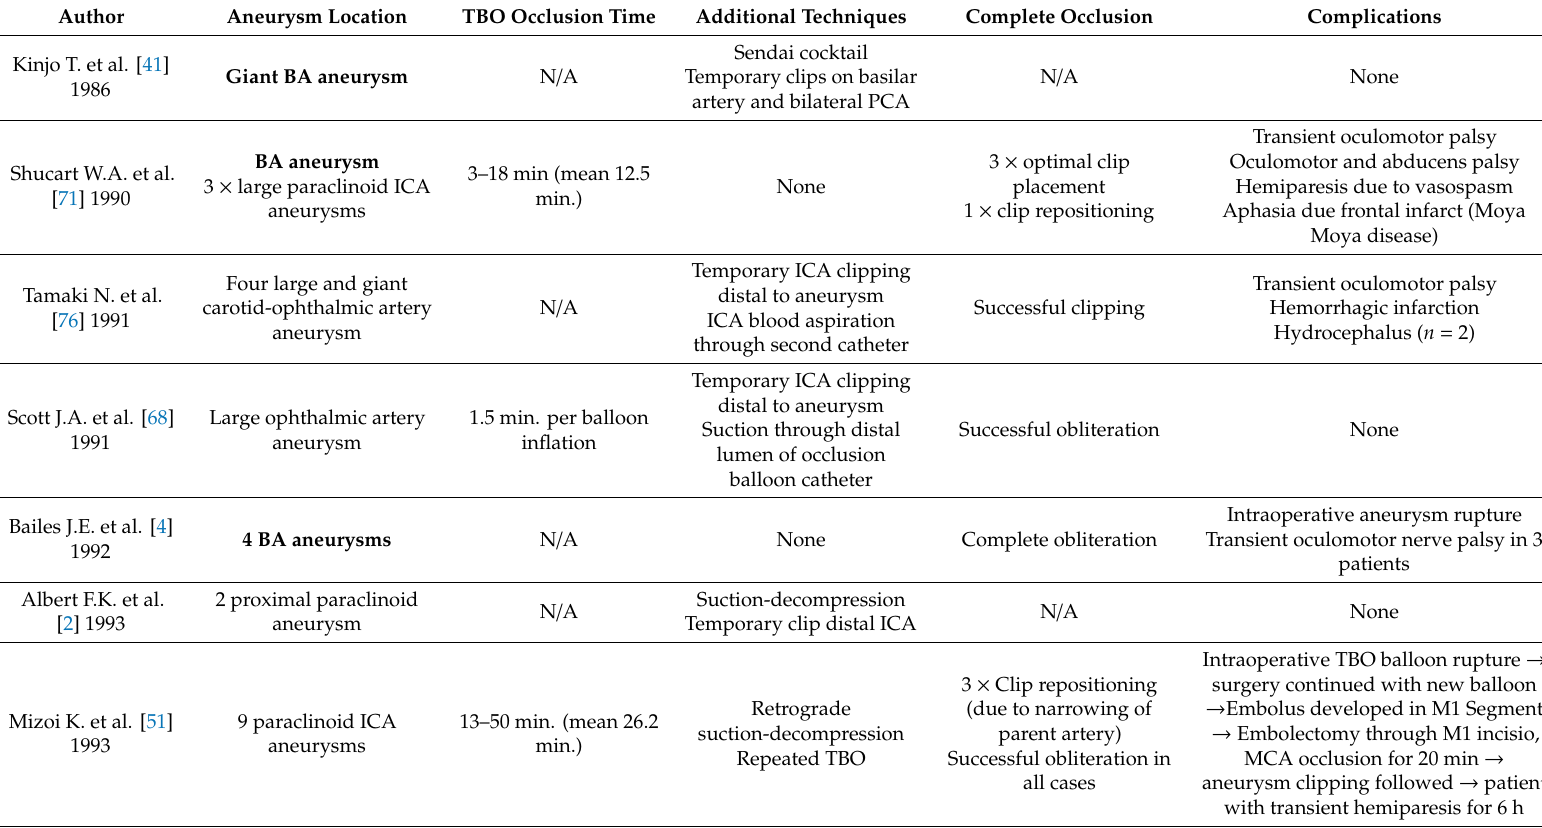
Table 3. Overview of all aneurysm cases including clipping with TBO in the literature. Information includes aneurysm characteristics, TBO duration, additional techniques, aneurysm occlusion status and complications. All posterior circulation aneurysms and complications related to TBO are listed in bold